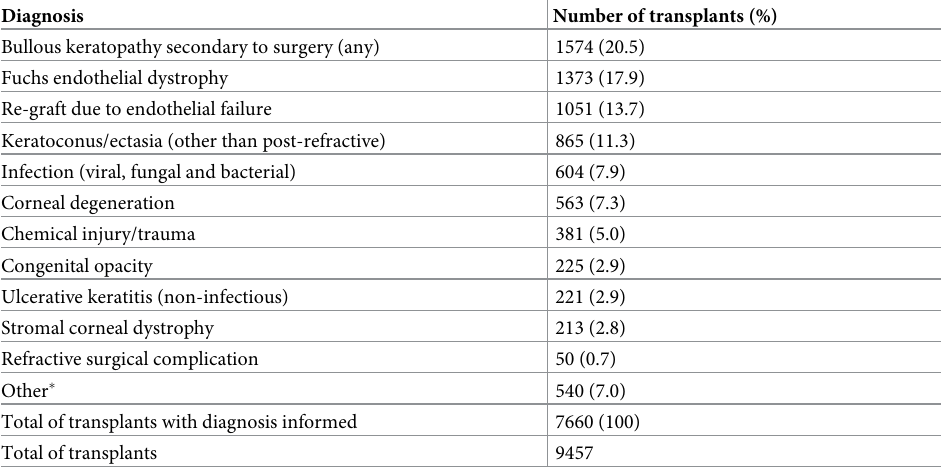
Table 1. Indications reported for corneal transplantation from January 2011 to December 2018 in Catalonia